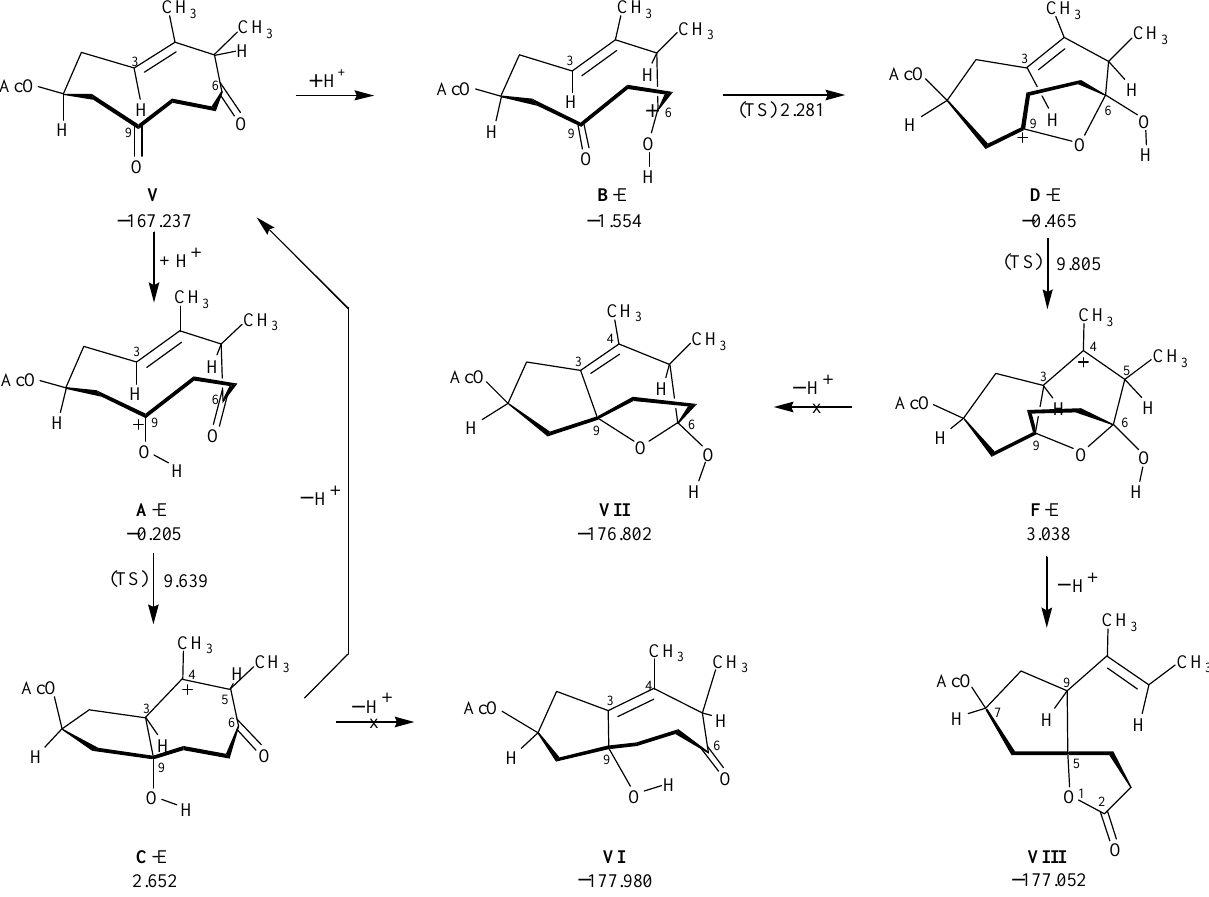
Figure 2. Results of the calculations for ( E )-isomer. Heats of formation of the intermediates and prod- ucts of the corresponding transition states (TS) are given in